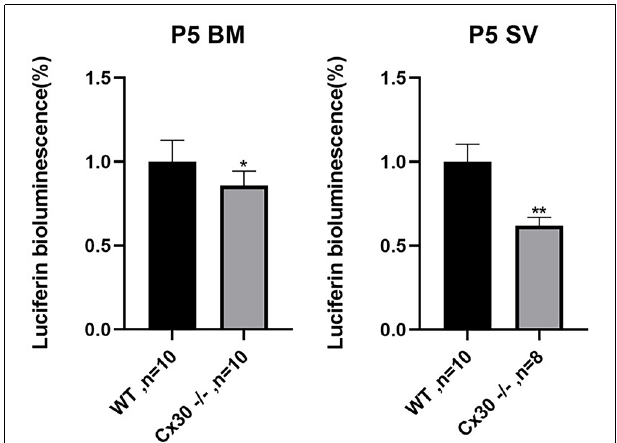
FIGURE 7 | Reduction of ATP release in the cochlea in Cx30 -/- mice. ATP release is reduced in Cx30 -/- mice in BM and SV at P5. Data presented as Mean ± SEM. t -test. * p < 0.05, ** p < 0.01. BM, basemental membrane; SV, stria